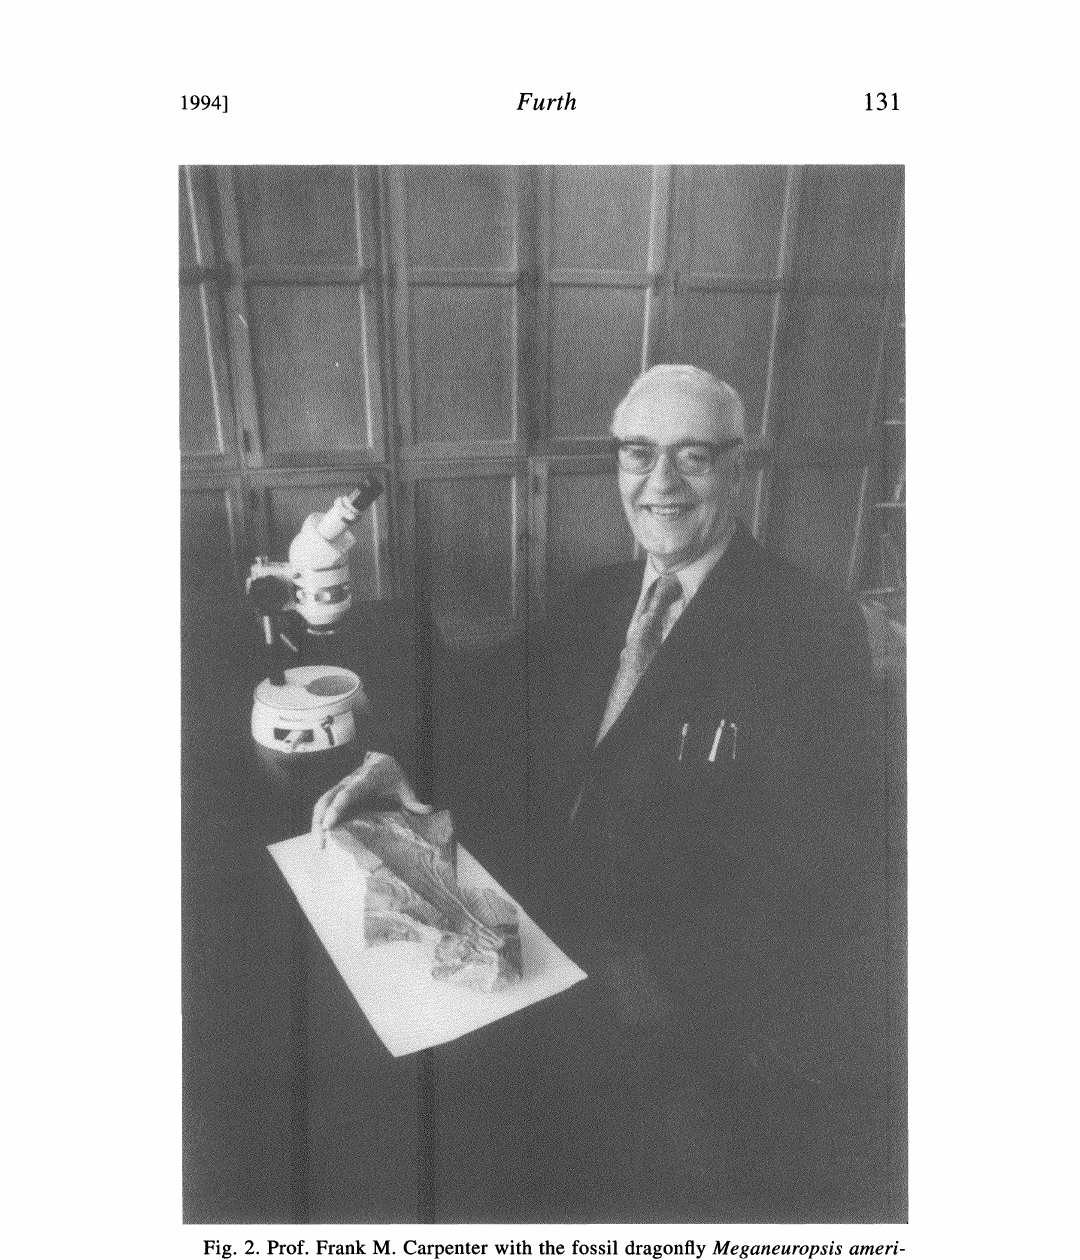
Fig. 2. Prof. Frank M. Carpenter with the fossil dragonfly Meganeuropsis ameri- cana Carpenter, the largest known insect. (photo taken at about the time of his retirement in 1973, photographer unknown to